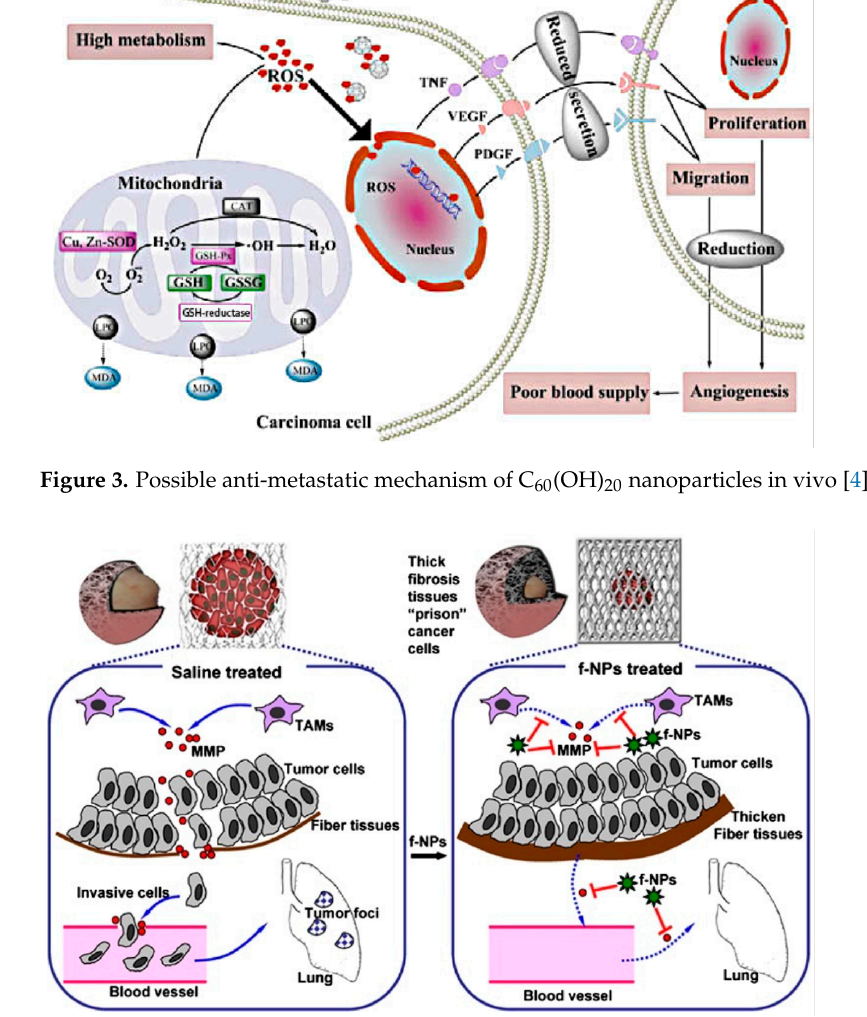
Figure 4. Mechanism by which Gd@C 82 (OH) 22 block carcinoma metastasis mainly via an MMP- inhibition process. The thick fibrous cage might serve as a ‘prison’ to tightly confine invasive tumor cells within the primary siteb